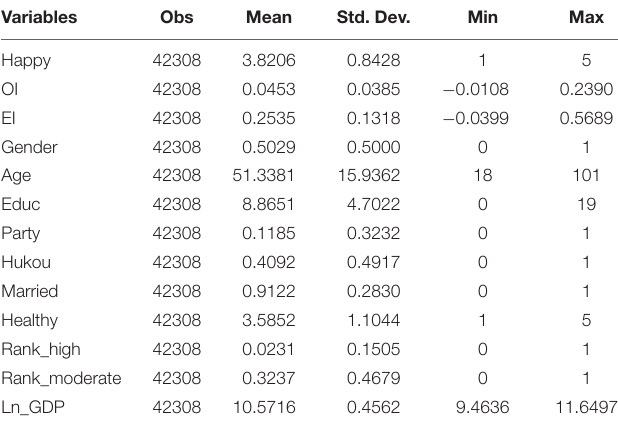
TABLE 2 | Descriptive statistics for the